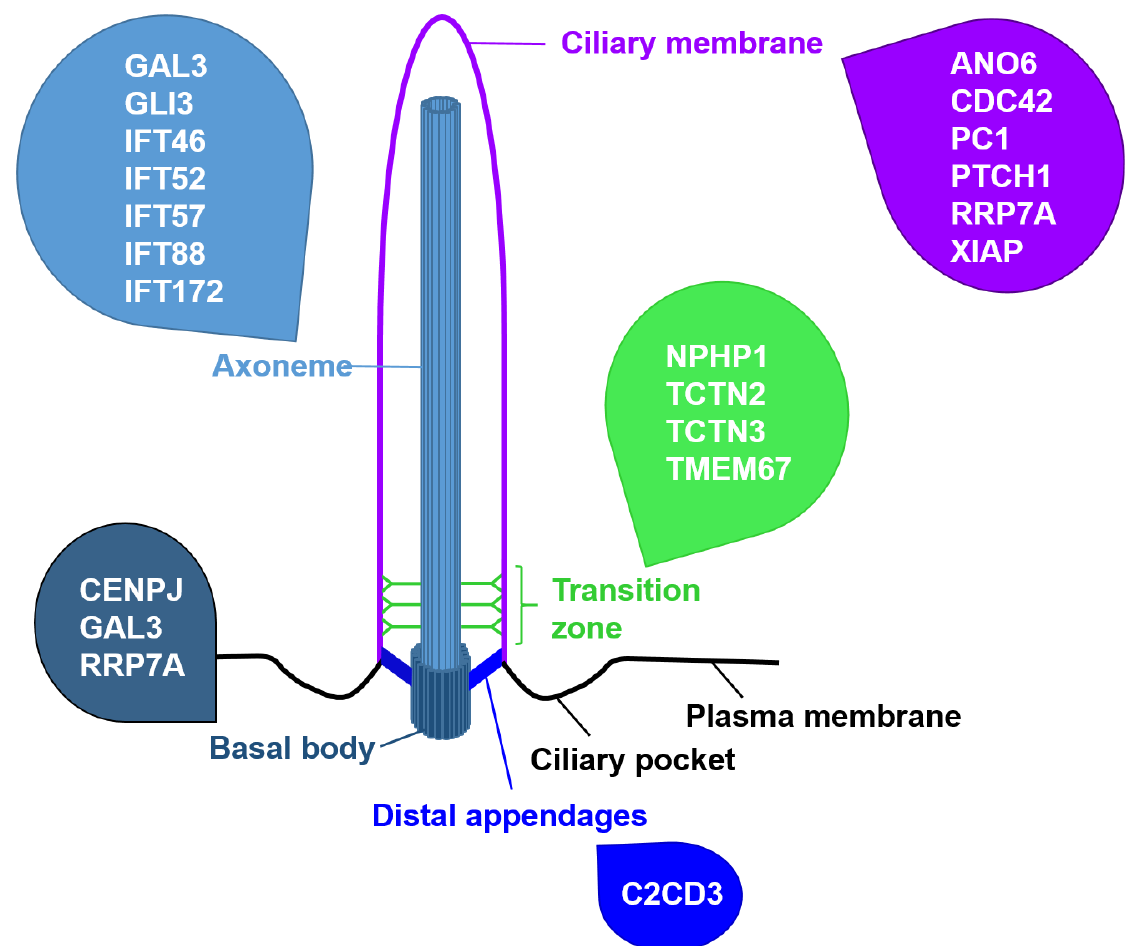
Figure 1. Schematic ciliary structure and subciliary localisation of proteins regulating cell death. Cell death-governing proteins are present at nearly every region of the cilium.